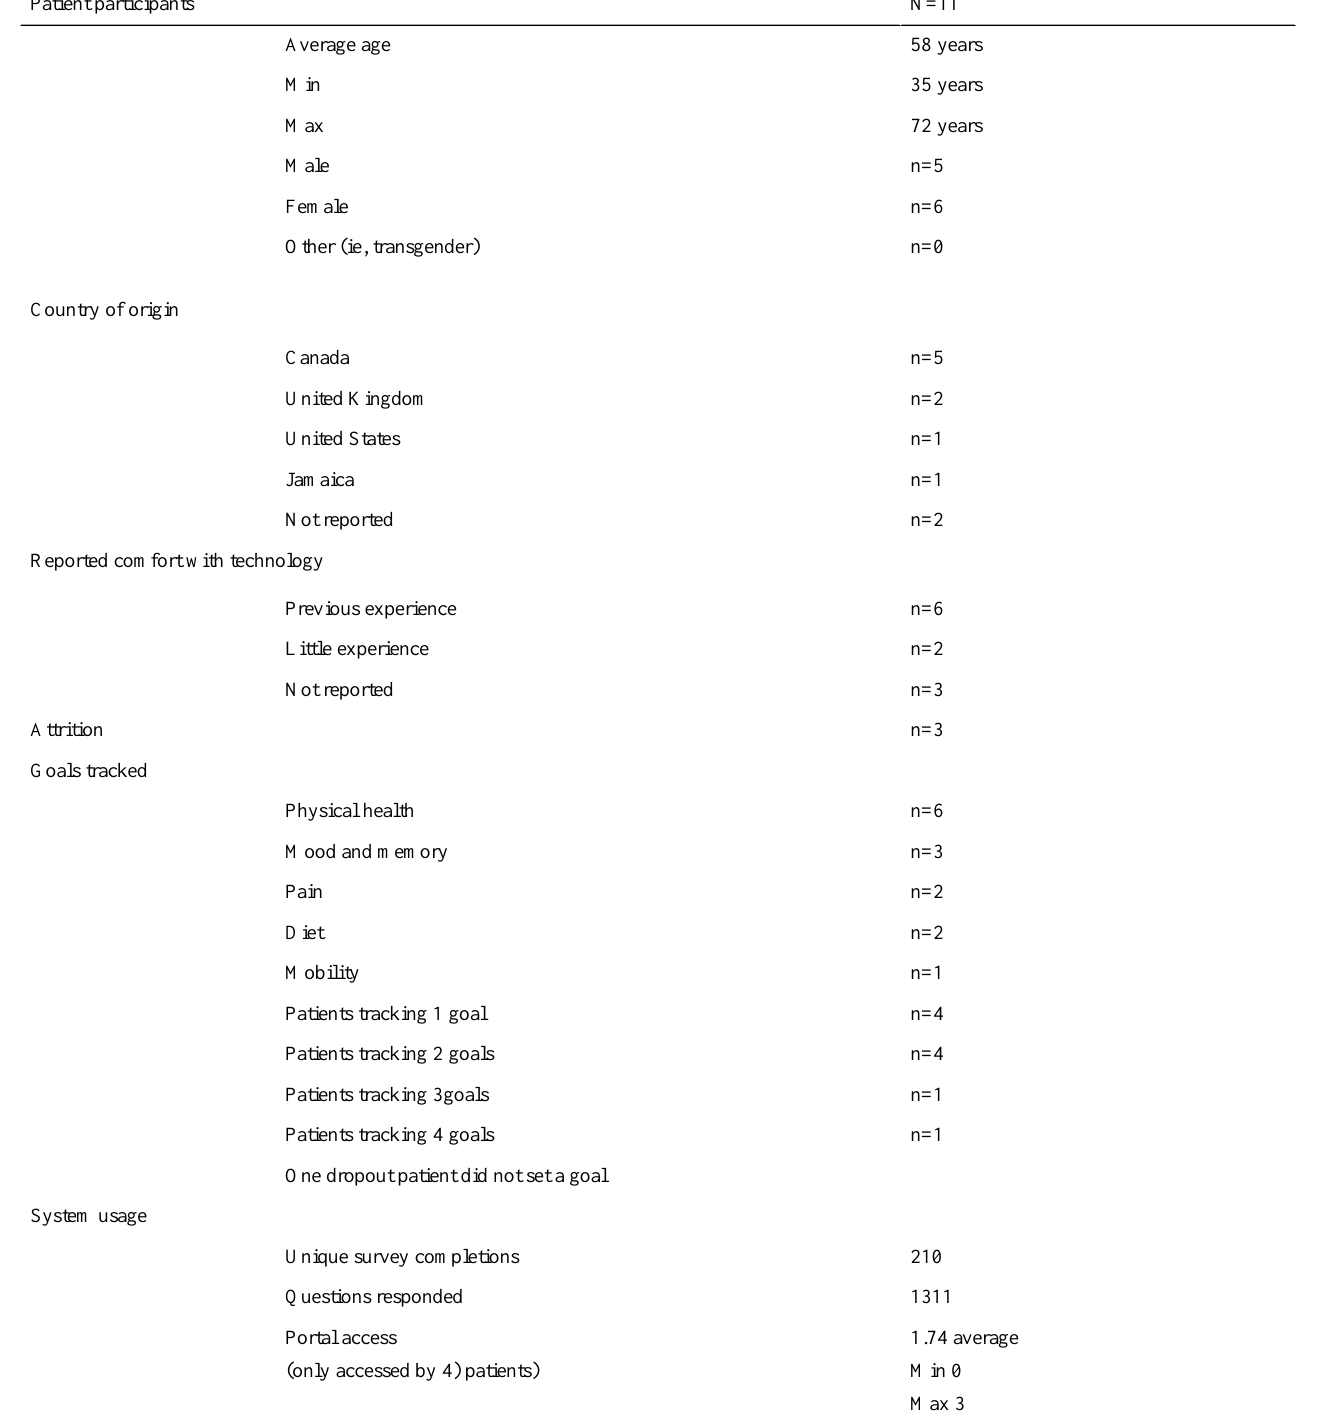
Table 2. Patient demographics, goal monitoring activities, and system